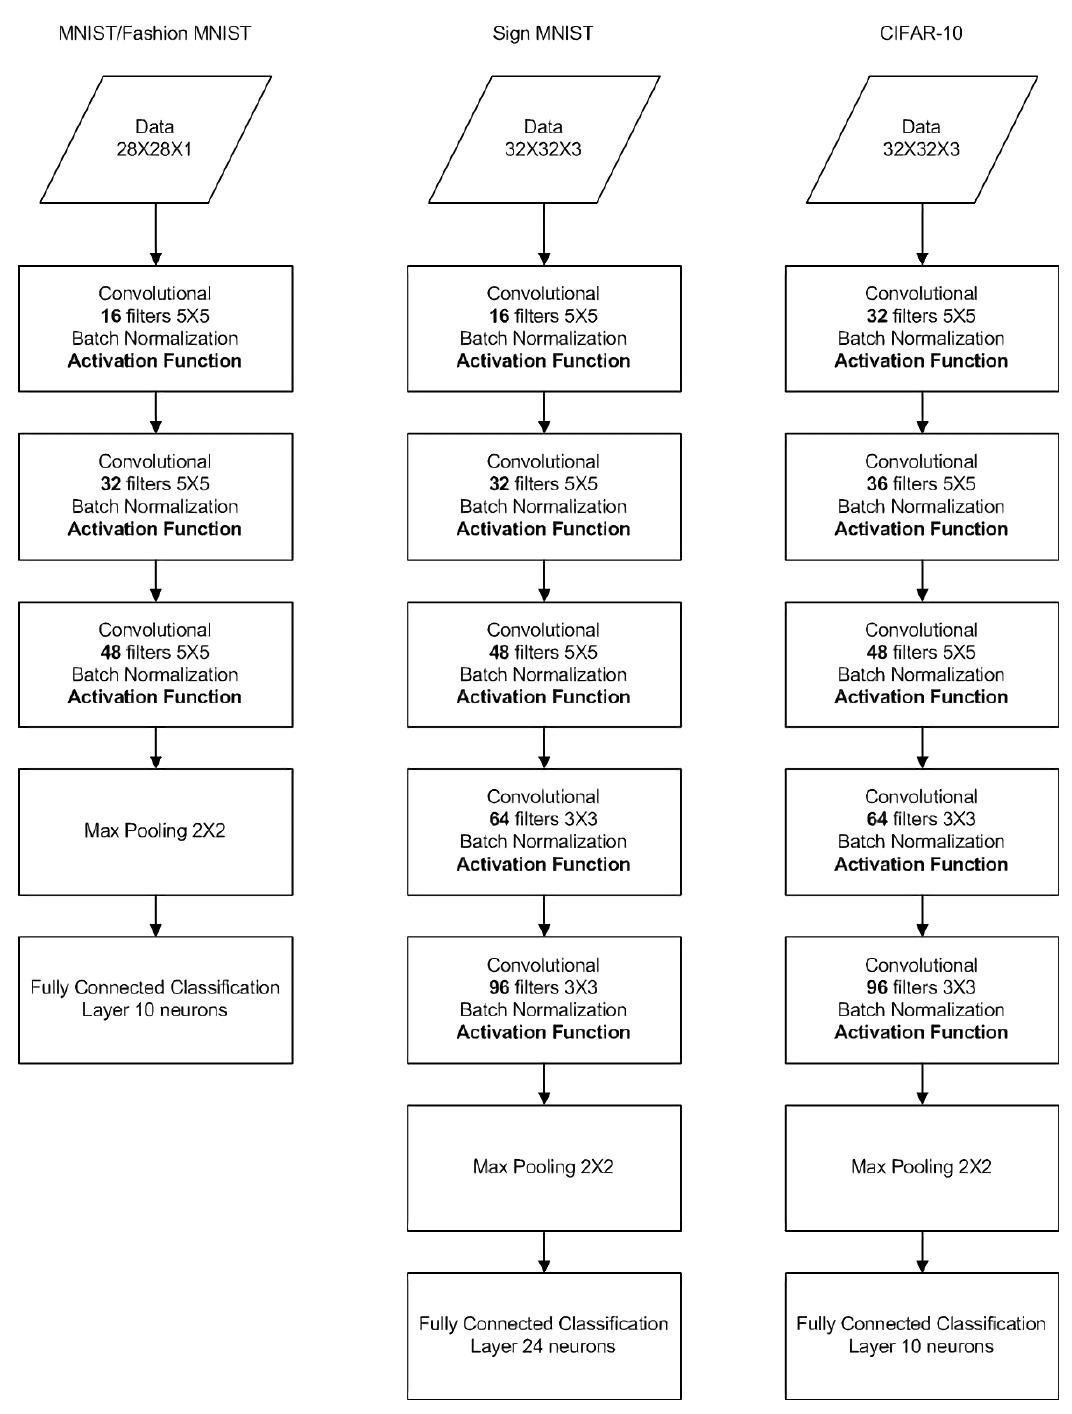
Figure 2. Neural networks’ topologies that were employed for each dataset (MNIST, Fashion MNIST, Sign MNIST and CIFAR-10).